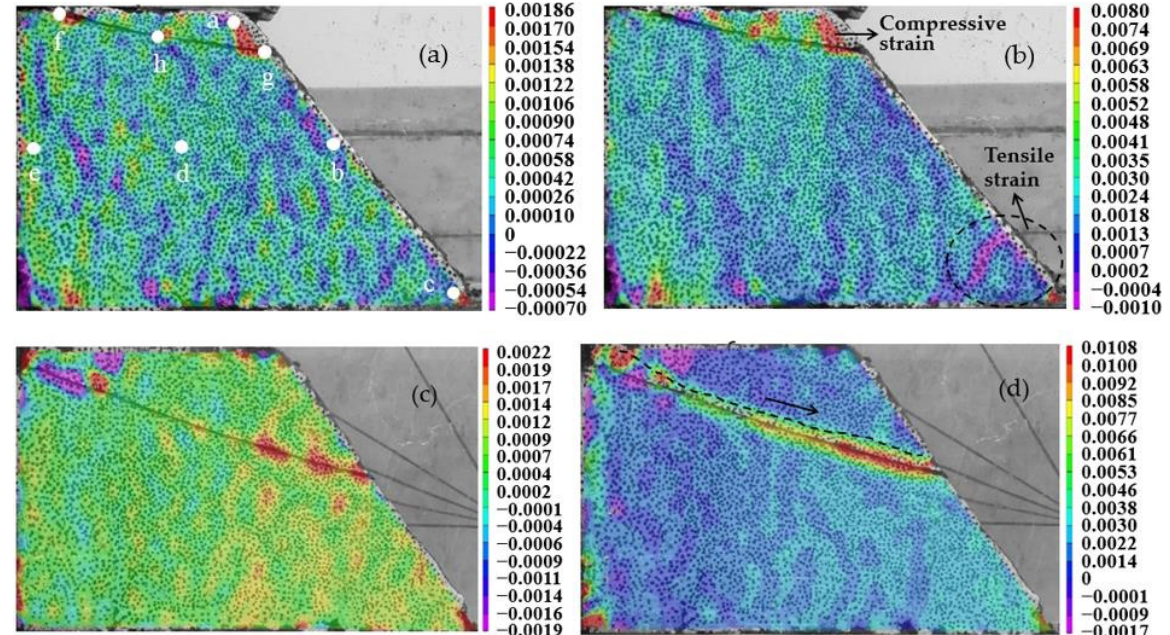
Figure 8. Strain contours of the slope model with one crack at an angle of 10° and 20° under different loadings. ( a ) Under 1.6 MPa at 10°; ( b ) under 16 MPa at 10°; ( c ) under 1.6 MPa at 20°; ( d ) under 16 MPa at 20°.